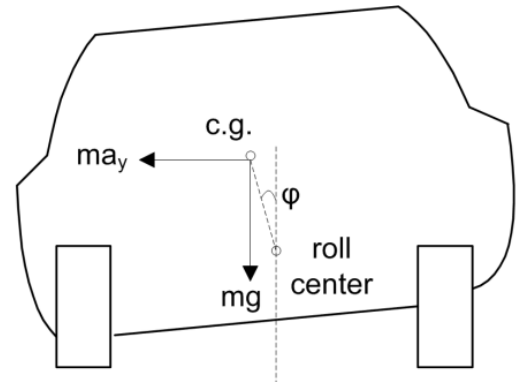
Figure 2. Roll dynamics analysis.